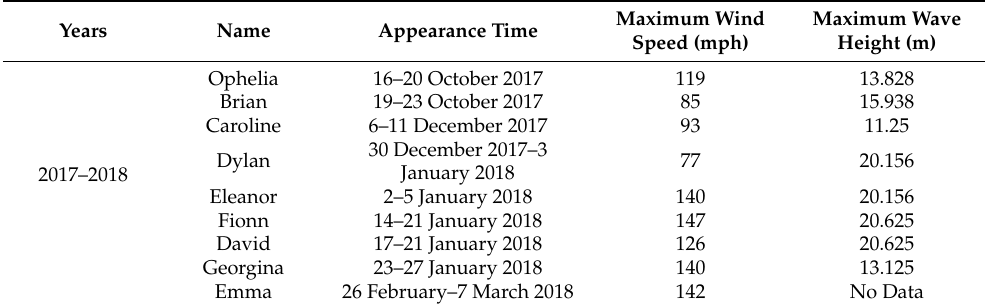
Table 4. Storms affecting the northeast Atlantic between 18 September 2017 (survey in 2017) and 24 May 2019 (survey in 2019), with references to the maximum wave height and wind speed recorded in each